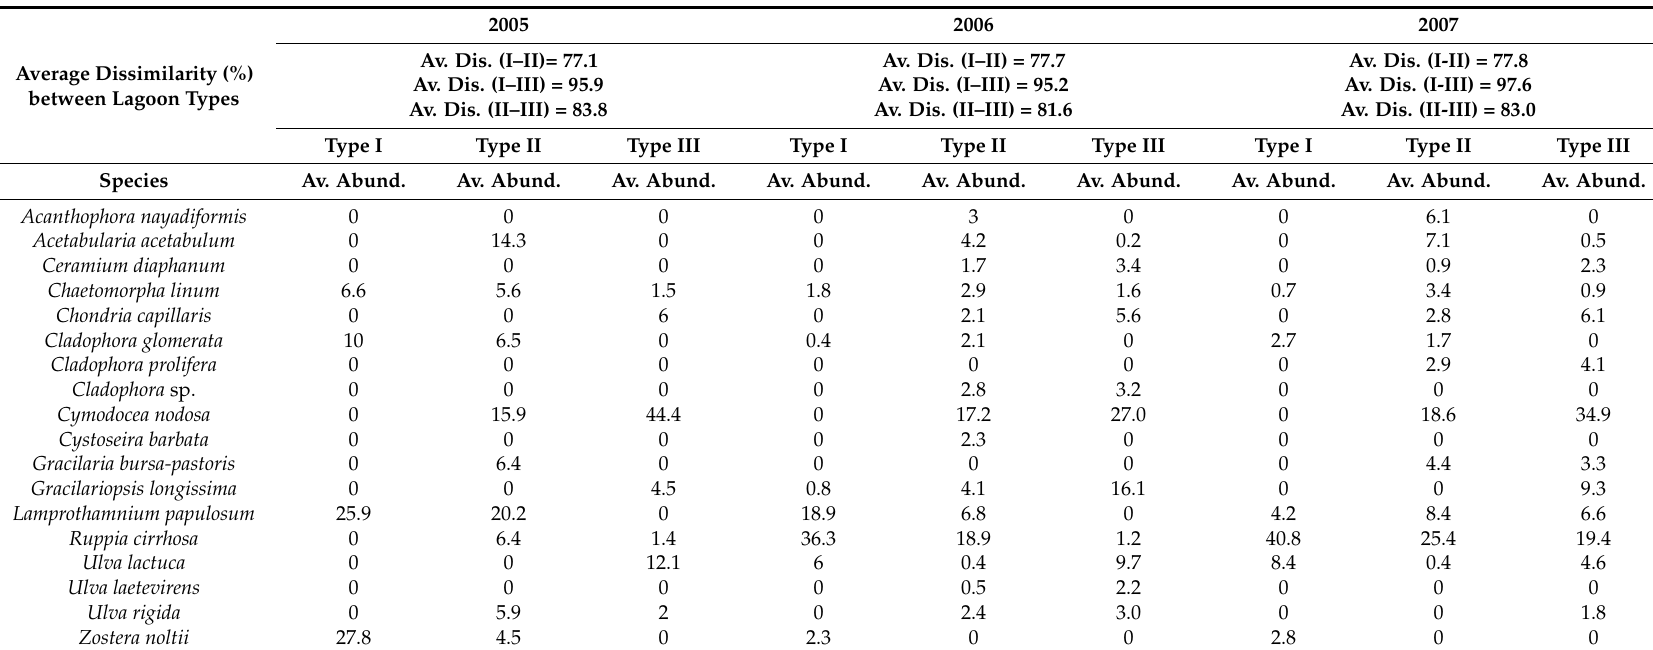
Table 3. SIMPER (similarity percentage) analysis results: average dissimilarity (%) within the three lagoon types of Western Greece during the three years 2005, 2006 and 2007. The macrophyte species primarily responsible for differences between macrophyte assemblages and its contribution within the lagoon type are also reported.